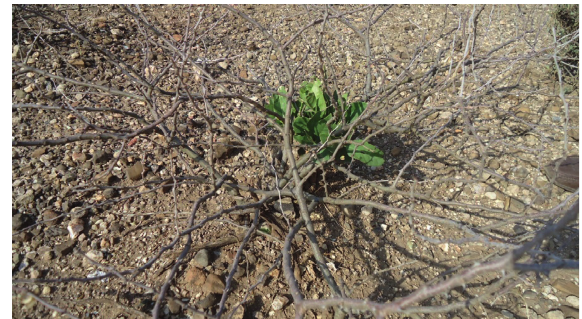
Figure 8: Seedling D. glabra emerging inside a thorny Acacia species.